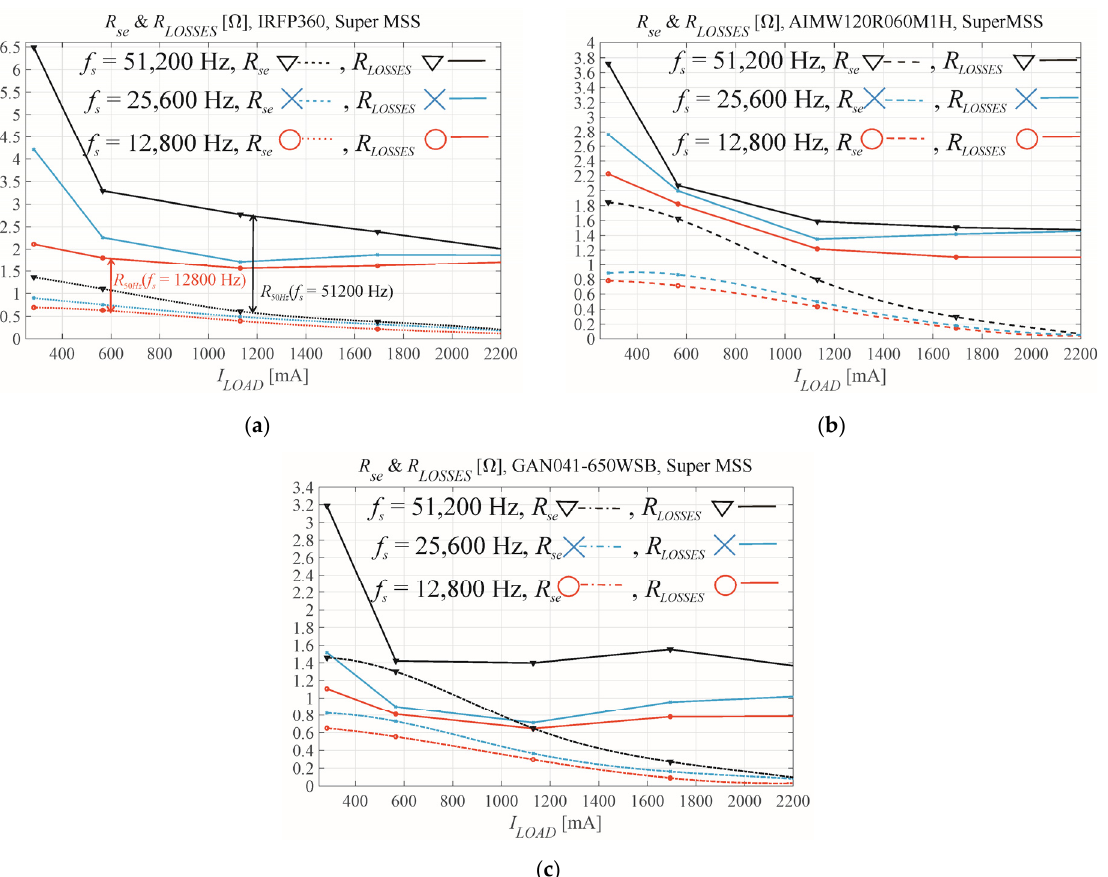
Figure 11. The serial resistances R se and R LOSSES for ( a ) Si, ( b ) SiC, and ( c ) GaN transistors when using coil core material Super